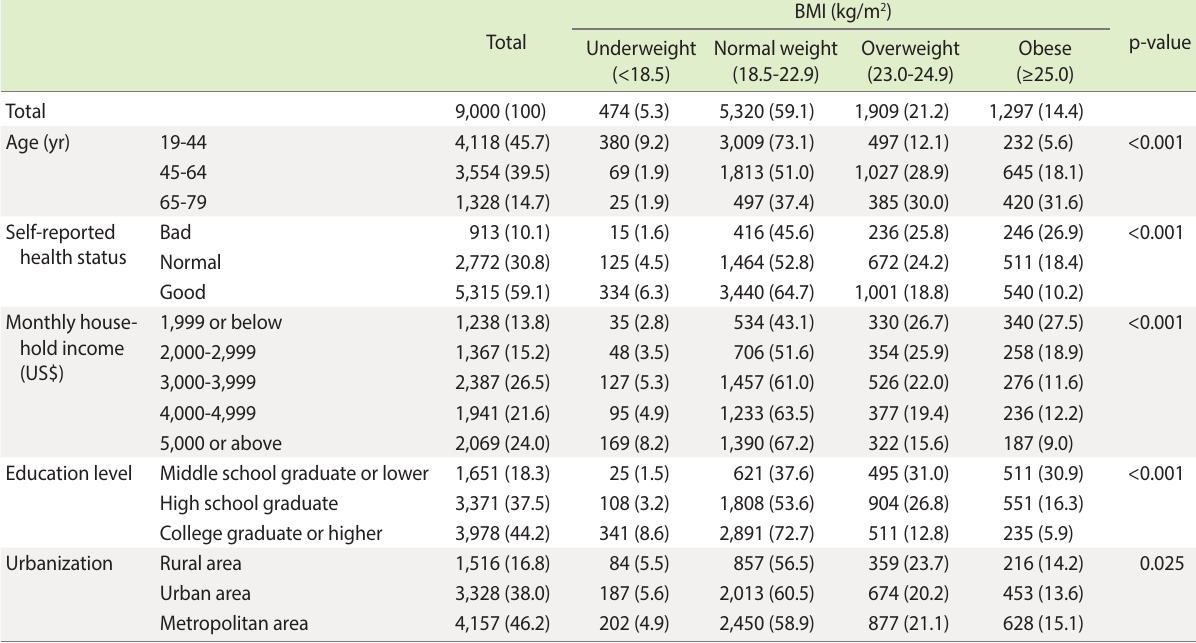
Table 1. Baseline characteristics of the study population in Korea according to body mass index